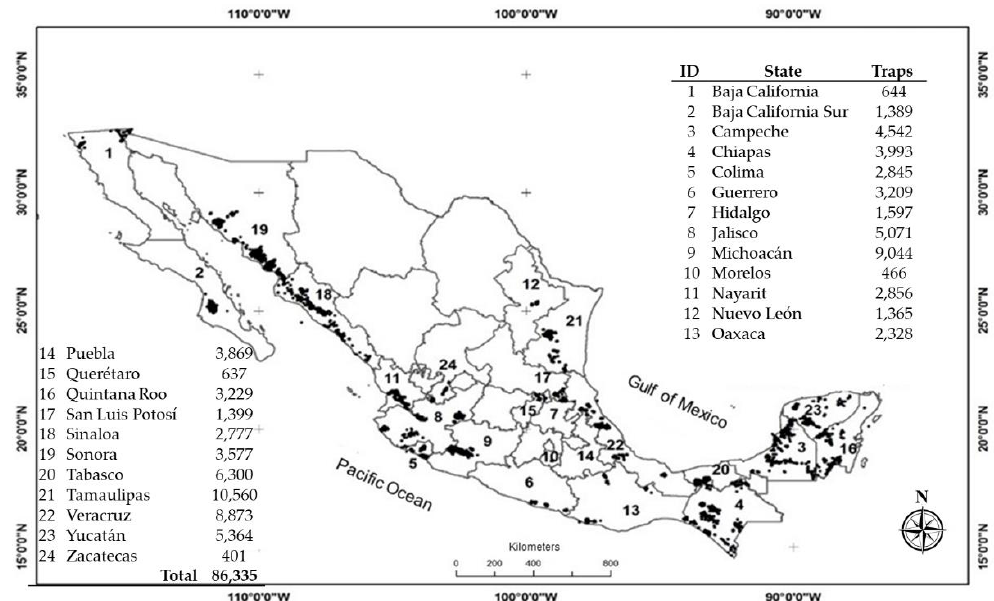
Figure 1. Number and geographic distribution of the yellow sticky traps used in the Mexican trapping system for the monitoring of the Asian citrus psyllid.